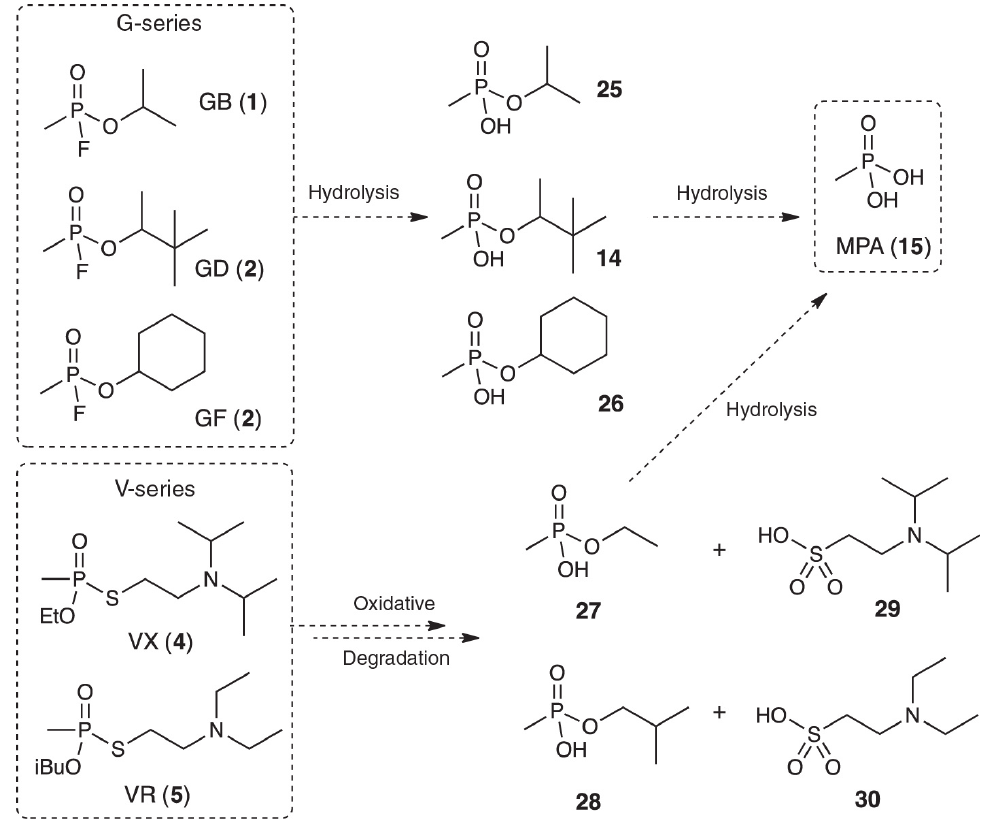
Figure 4: Degradation pathways of nerve agents leading to the formation of highly diagnostic half phosphonic acid esters and methylphosphonic acid ( 15